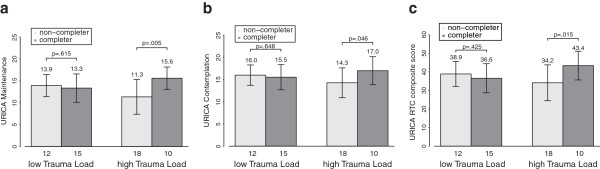
Interaction effect of Trauma Load and VSS-K/URICA scores on treatment completion. We report mean and standard deviations of continuous VSS-K/URICA scores. Numbers below columns represent numbers of subjects in the respective groups. A) Maintenance subscale. B) Contemplation subscale, C) RCT composite score.